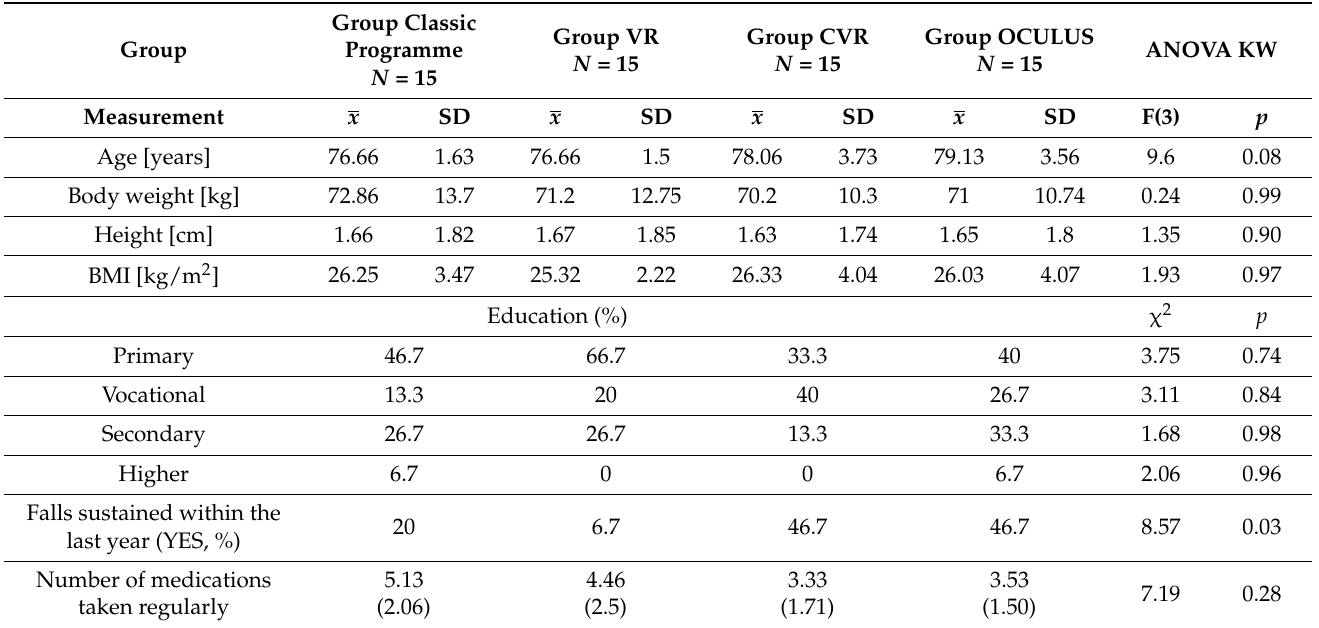
Figure 1. Recruitment process and the sizes of respective study groups. Table 1. Characteristics of respective study